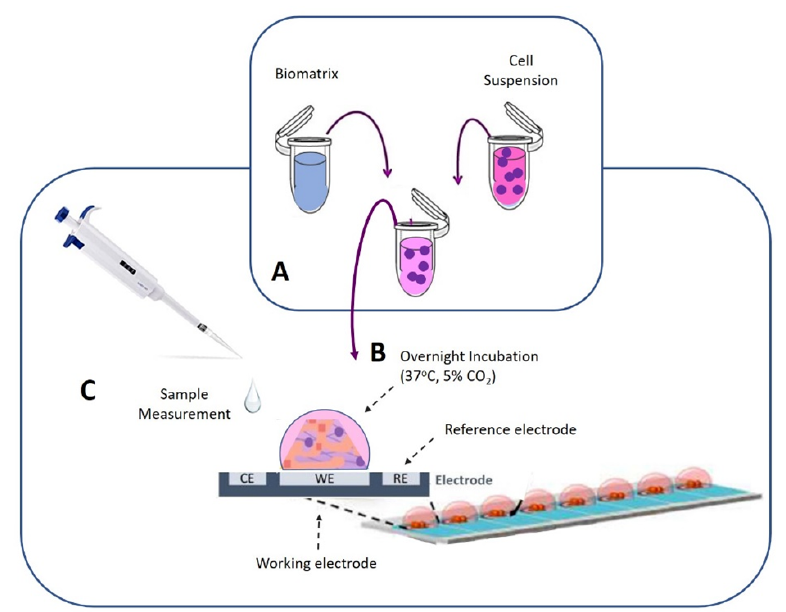
Figure 1. Cells were mixed with the hydrogel matrix ( A ) and were placed onto the working electrode’s surface. The electrodes were put in petri dishes and were incubated overnight at 37 ◦ C, 5% CO 2 ( B ). The next day the modified electrodes with the 3D cultures were ready for use ( C